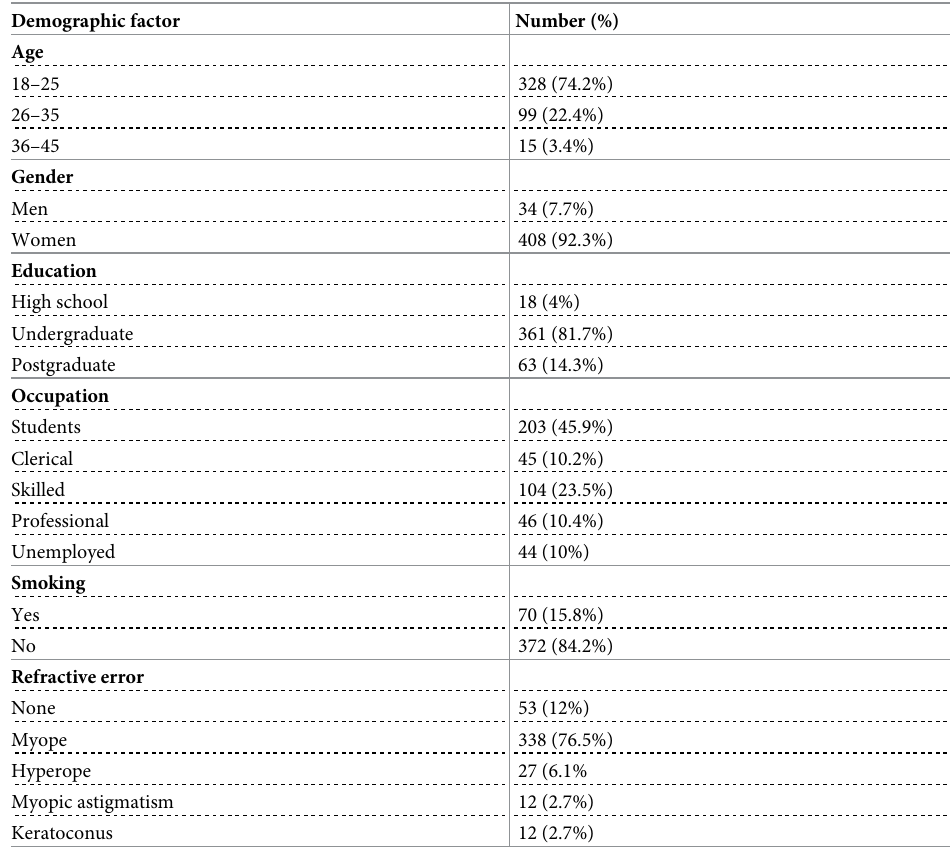
Table 1. Demographic and refractive error characteristics of participants (n =